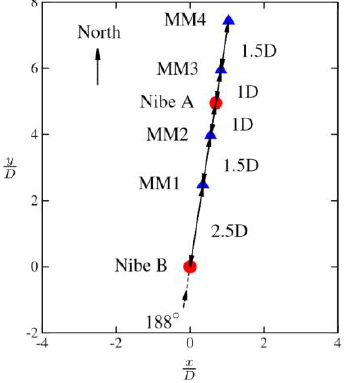
Figure 6. Calculation domain dimension design.